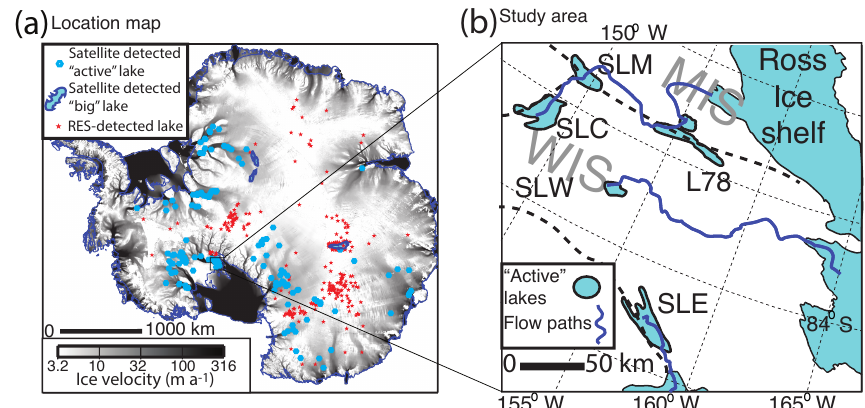
Figure 1. Maps of Antarctic subglacial lakes. (a) Antarctic subglacial lakes inventory showing detected “active” lakes, satellite-detected “big” lakes, and lakes detected by radio-echo-sounding (RES) (Wright and Siegert, 2012). Background grayscale corresponds to ice velocities from Rignot et al. (2011). (b) Zoomed-in map for Whillans–Mercer ice streams showing the lakes (SLM: subglacial Lake Mercer; SLC: subglacial Lake Conway; SLW: subglacial Lake Whillans; SLE: subglacial Lake Engelhardt; L78: Lake 7–8) and flow paths used in this study (see black box in panel (a) for